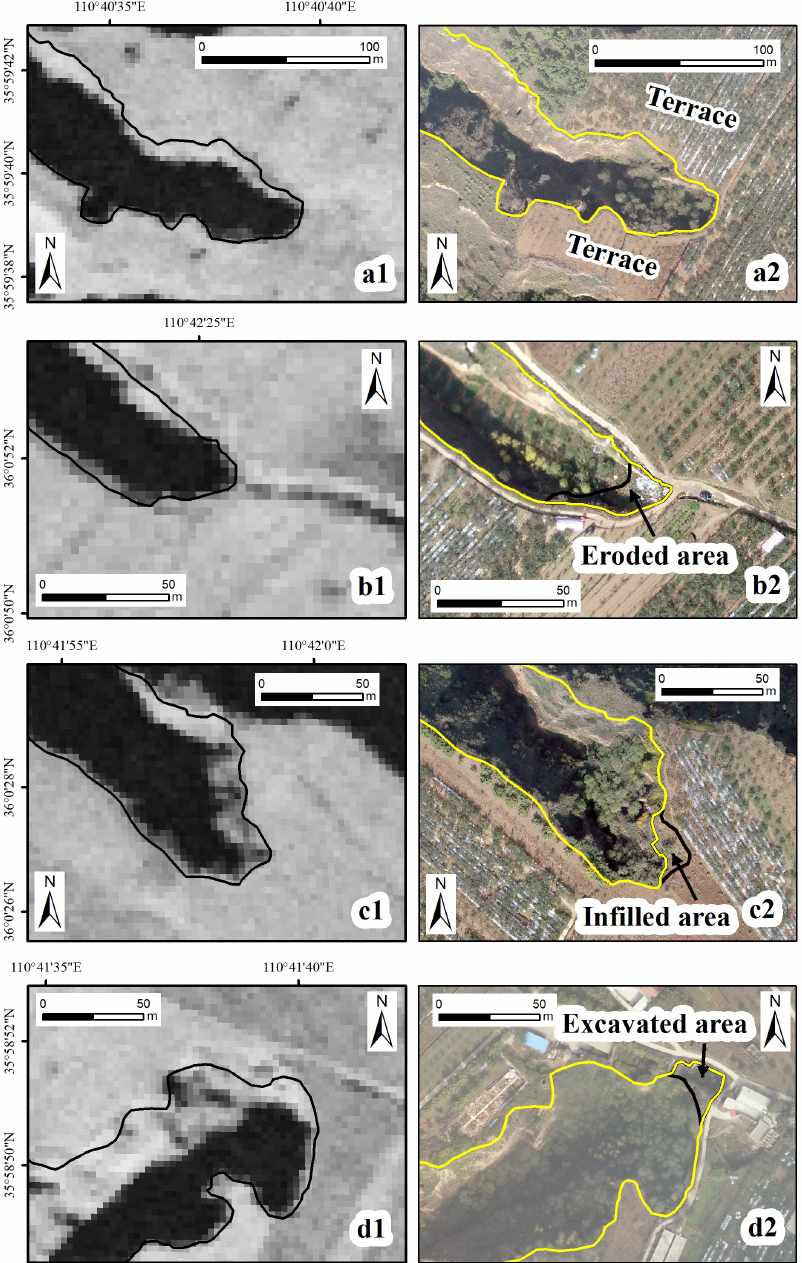
Figure 3. Examples of 4 gully types. ( a – d ) are stable, growing, infilled, and excavated gullies, respectively; (1) and (2) represent 1969 and 2019, respectively. Gully edge lines in 1969 and 2019 are colored in black and yellow, respectively.